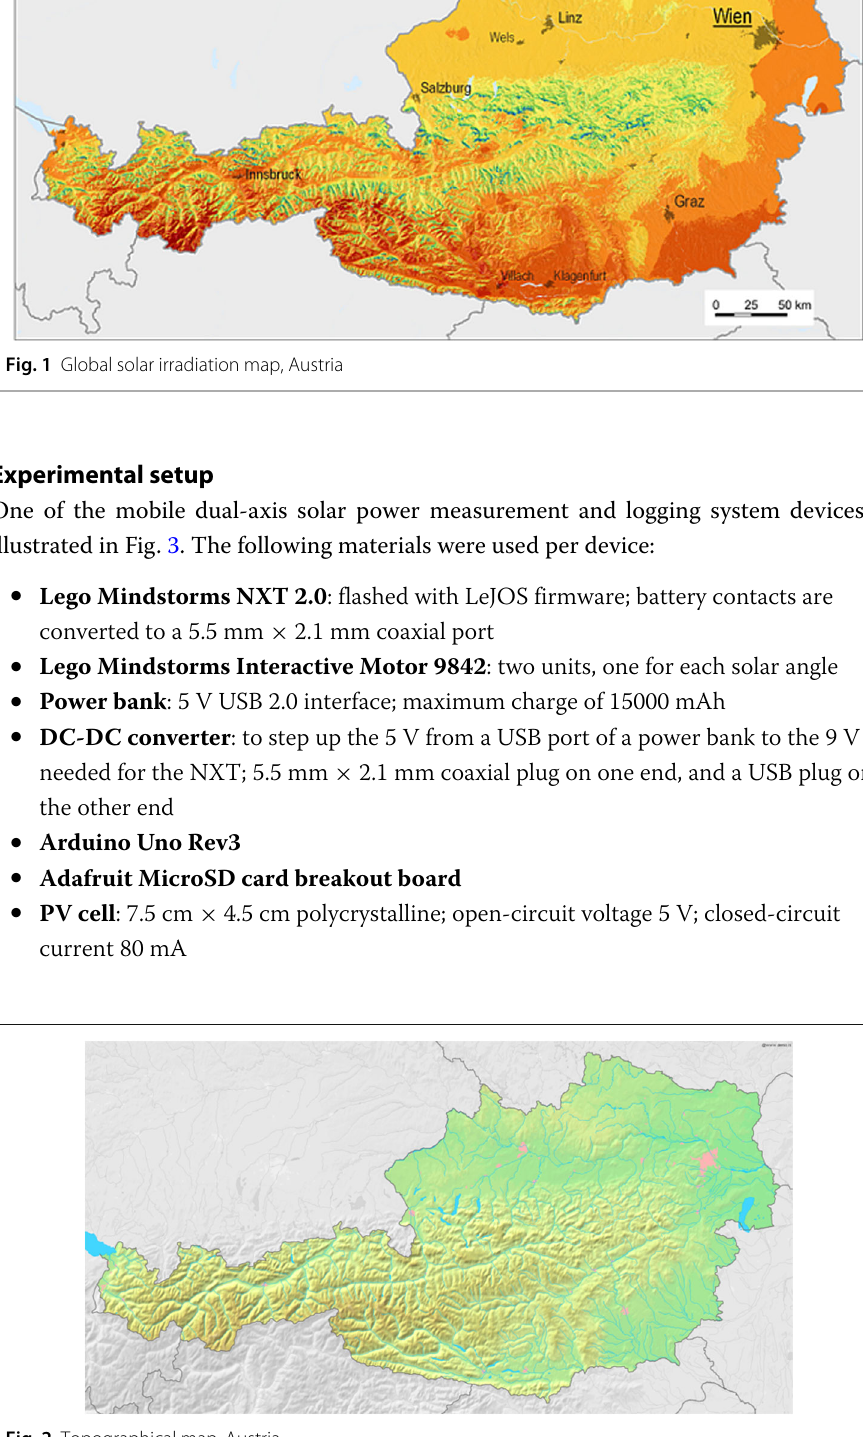
Fig. 1 Global solar irradiation map, Austria